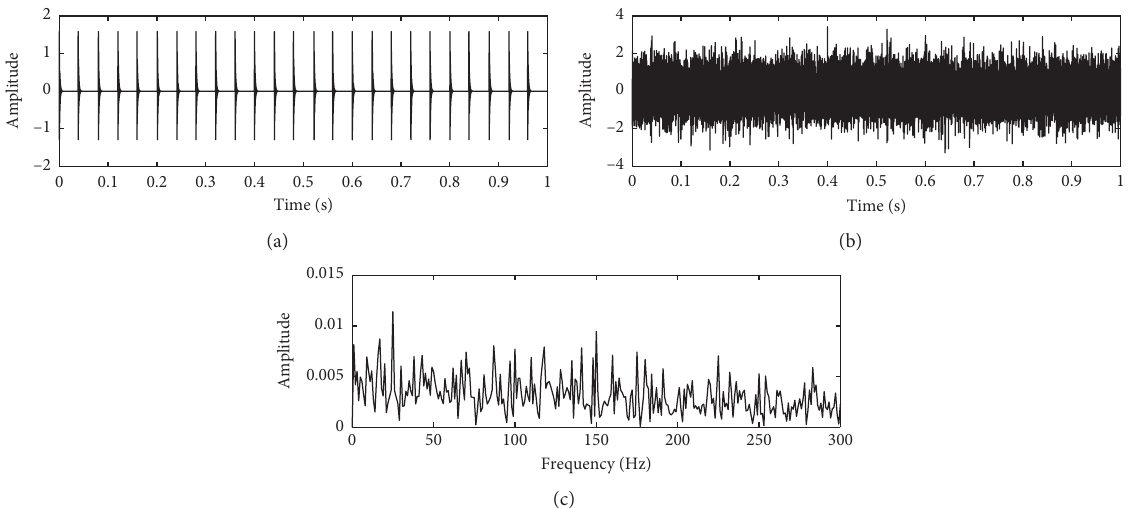
Figure 1: Outer race fault simulation signal of rolling element bearing: (a) simulation signal without noise; (b) simulation signal with strong background noise; (c) EDS of the signal as shown in Figure 1(b).